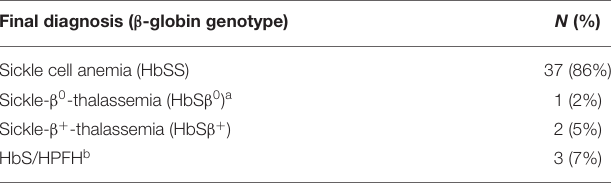
TABLE 1 | Results of molecular genetic testing as a component of newborn screening (NBS) for suspected sickle cell anemia (SCA). Final diagnosis ( β -globin genotype) N